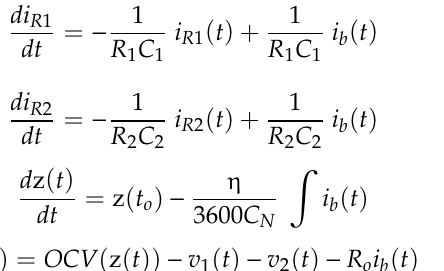
Table 2. Battery model parameters for Li-ion NMC cell at T = 20 ° C.